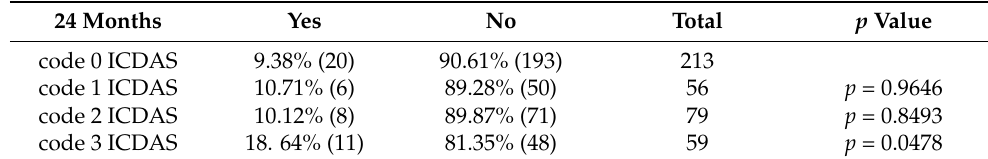
Table 9. Presence of carious lesions at 24 months.